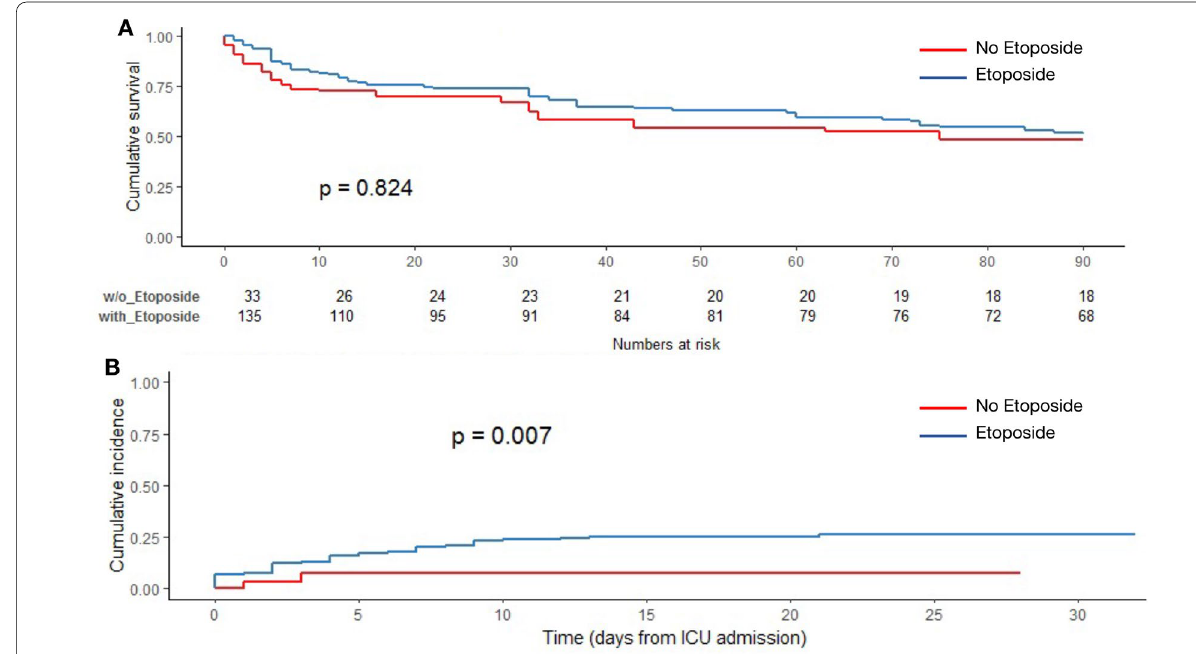
Fig. 3 Analysis after propensity score-based overlap weighting A Cumulative survival according to etoposide status (Kaplan–Meier estimates, log-rank’s test). B Cumulative incidence function (CIF) of HAIs according to etoposide status (Gray’s